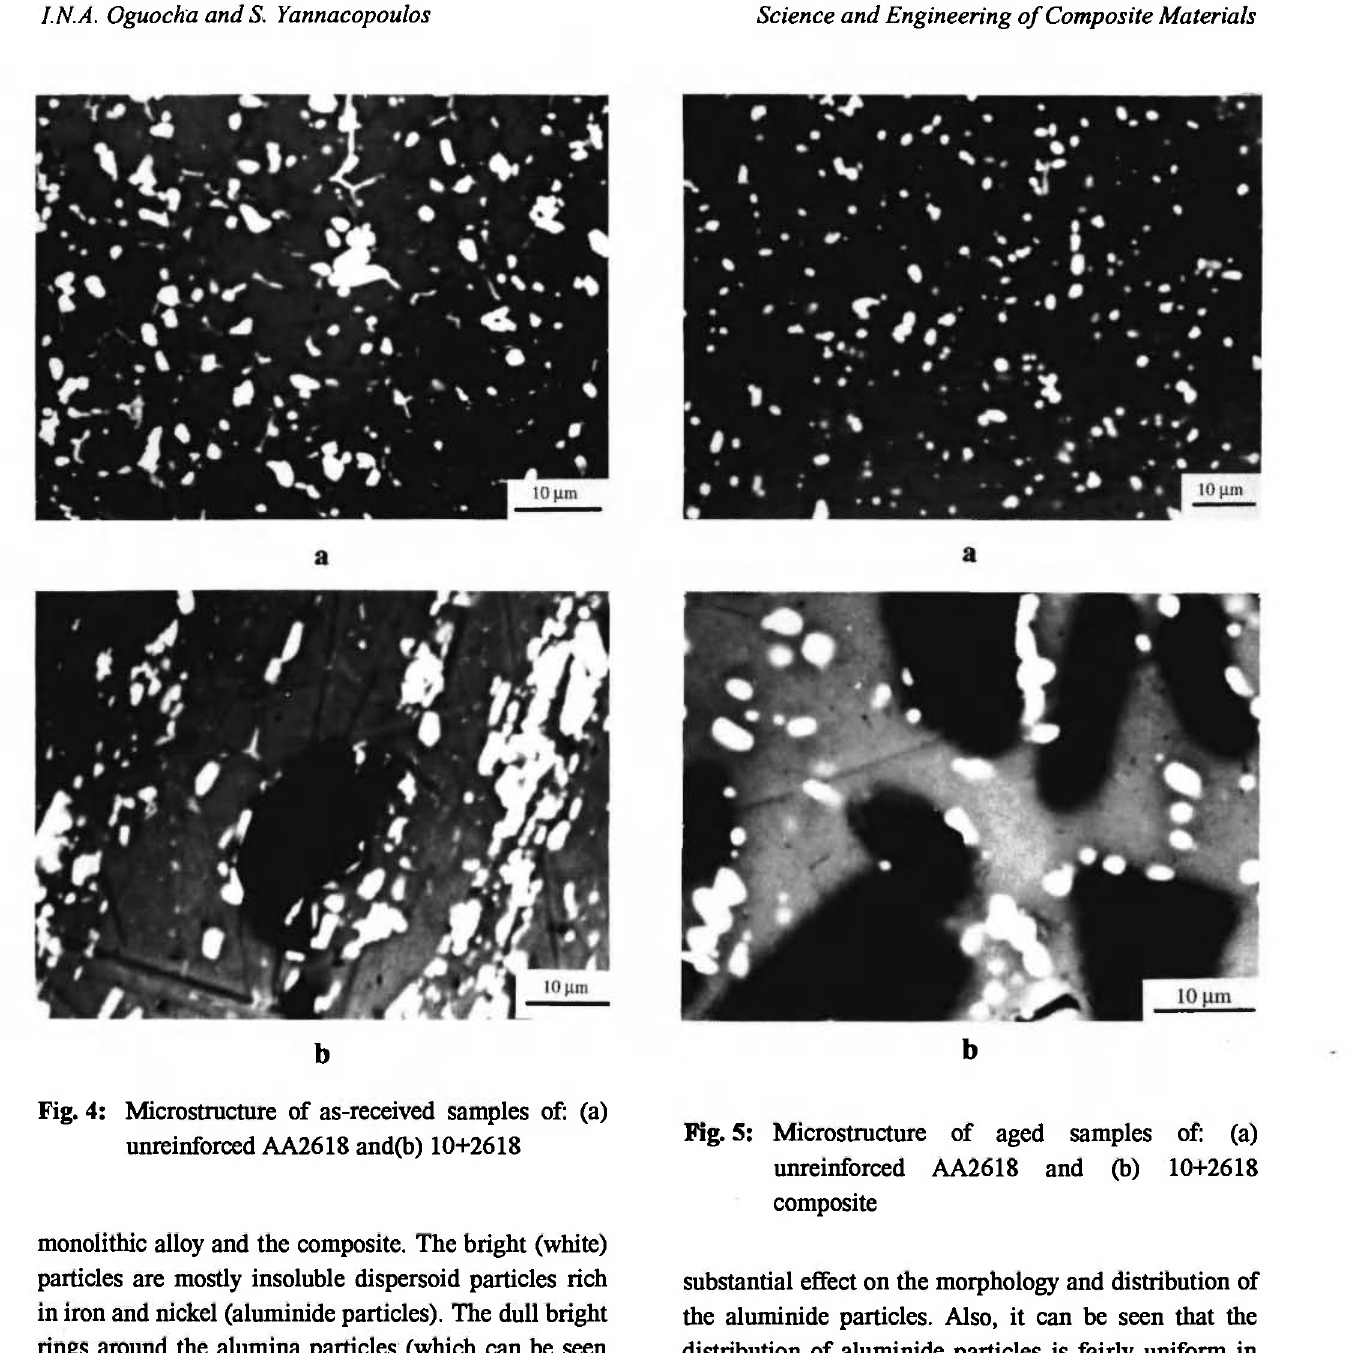
monolithic alloy and the composite. The bright (white) particles are mostly insoluble dispersoid particles rich rings around the alumina particles (which can be seen